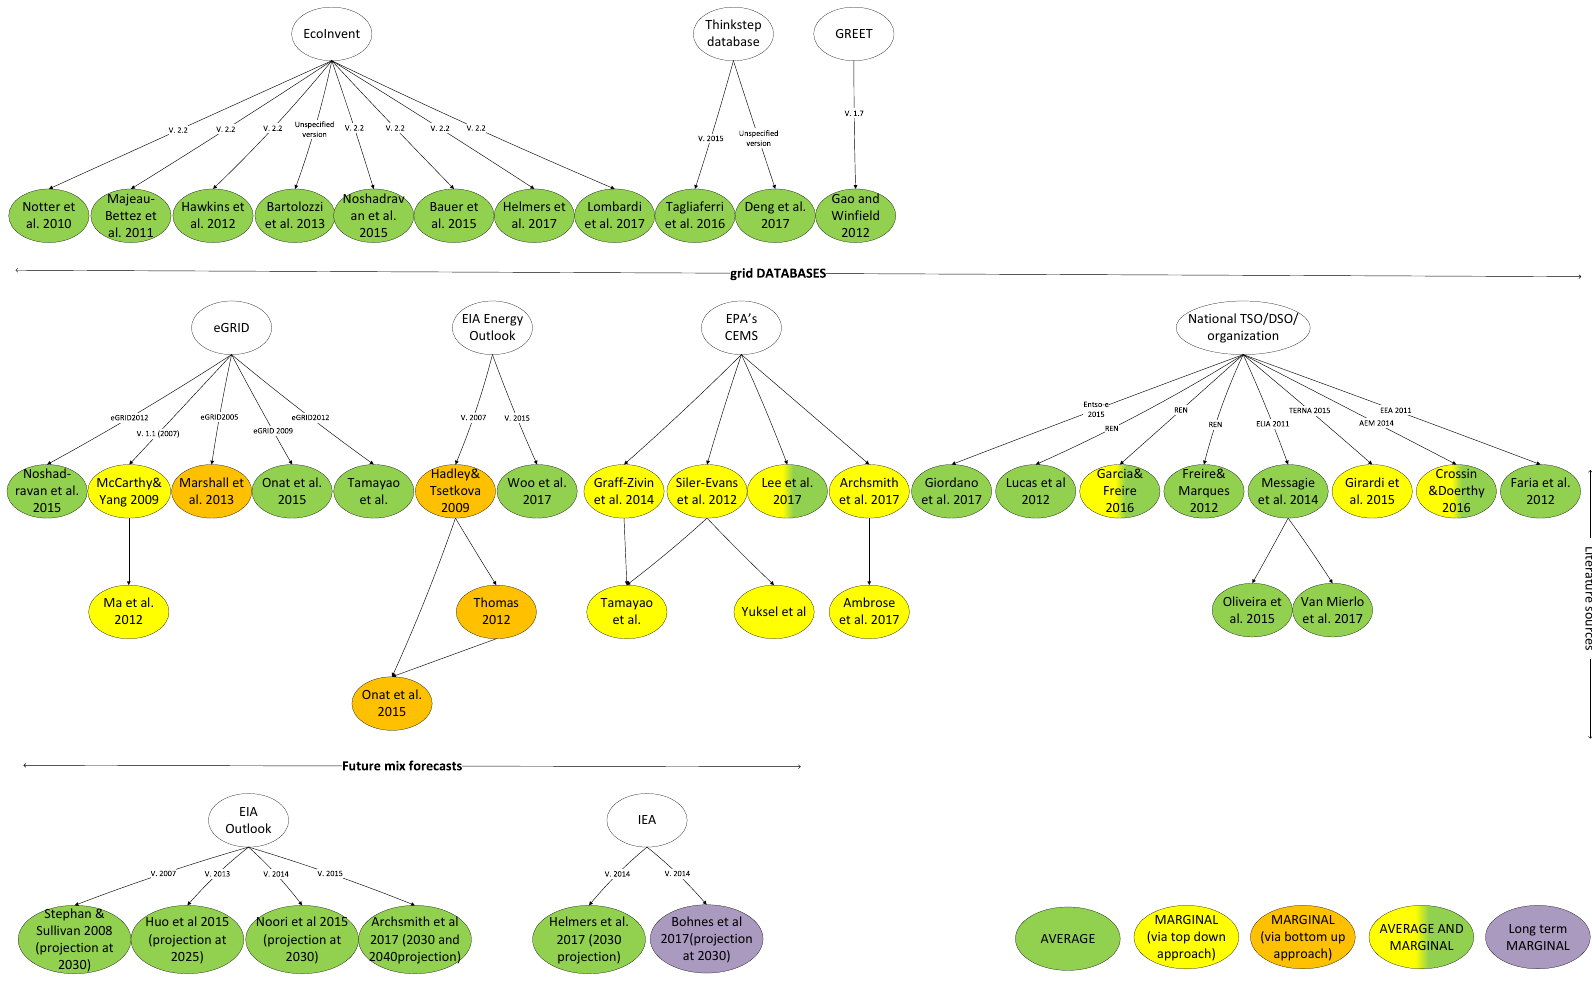
Figure 7. Sources of electricity mix’s data used in the reviewed papers.